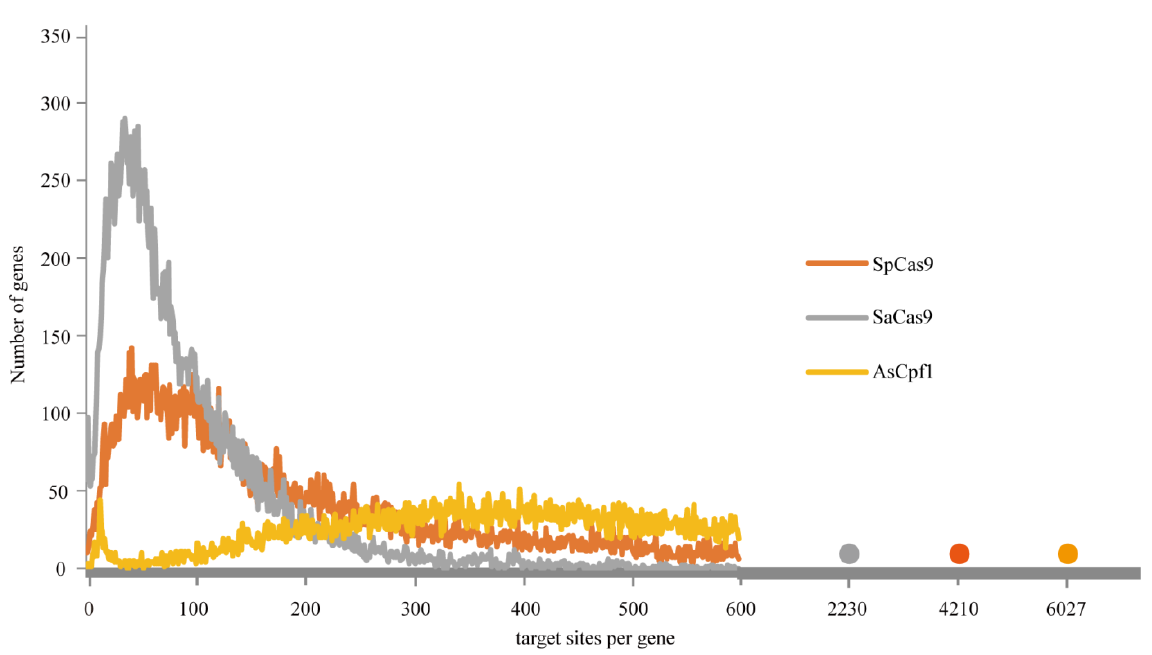
Figure 2. Bioinformatics analysis of CRISPR targeting sites on A. mellifera chromosome: ( a ) distribution of different target sites’ position on a chromosome. The red and green colour indicates high density and low density of CRISPR sites, respec- tively; ( b ) the average distance of two adjacent sites along the whole chromosome.